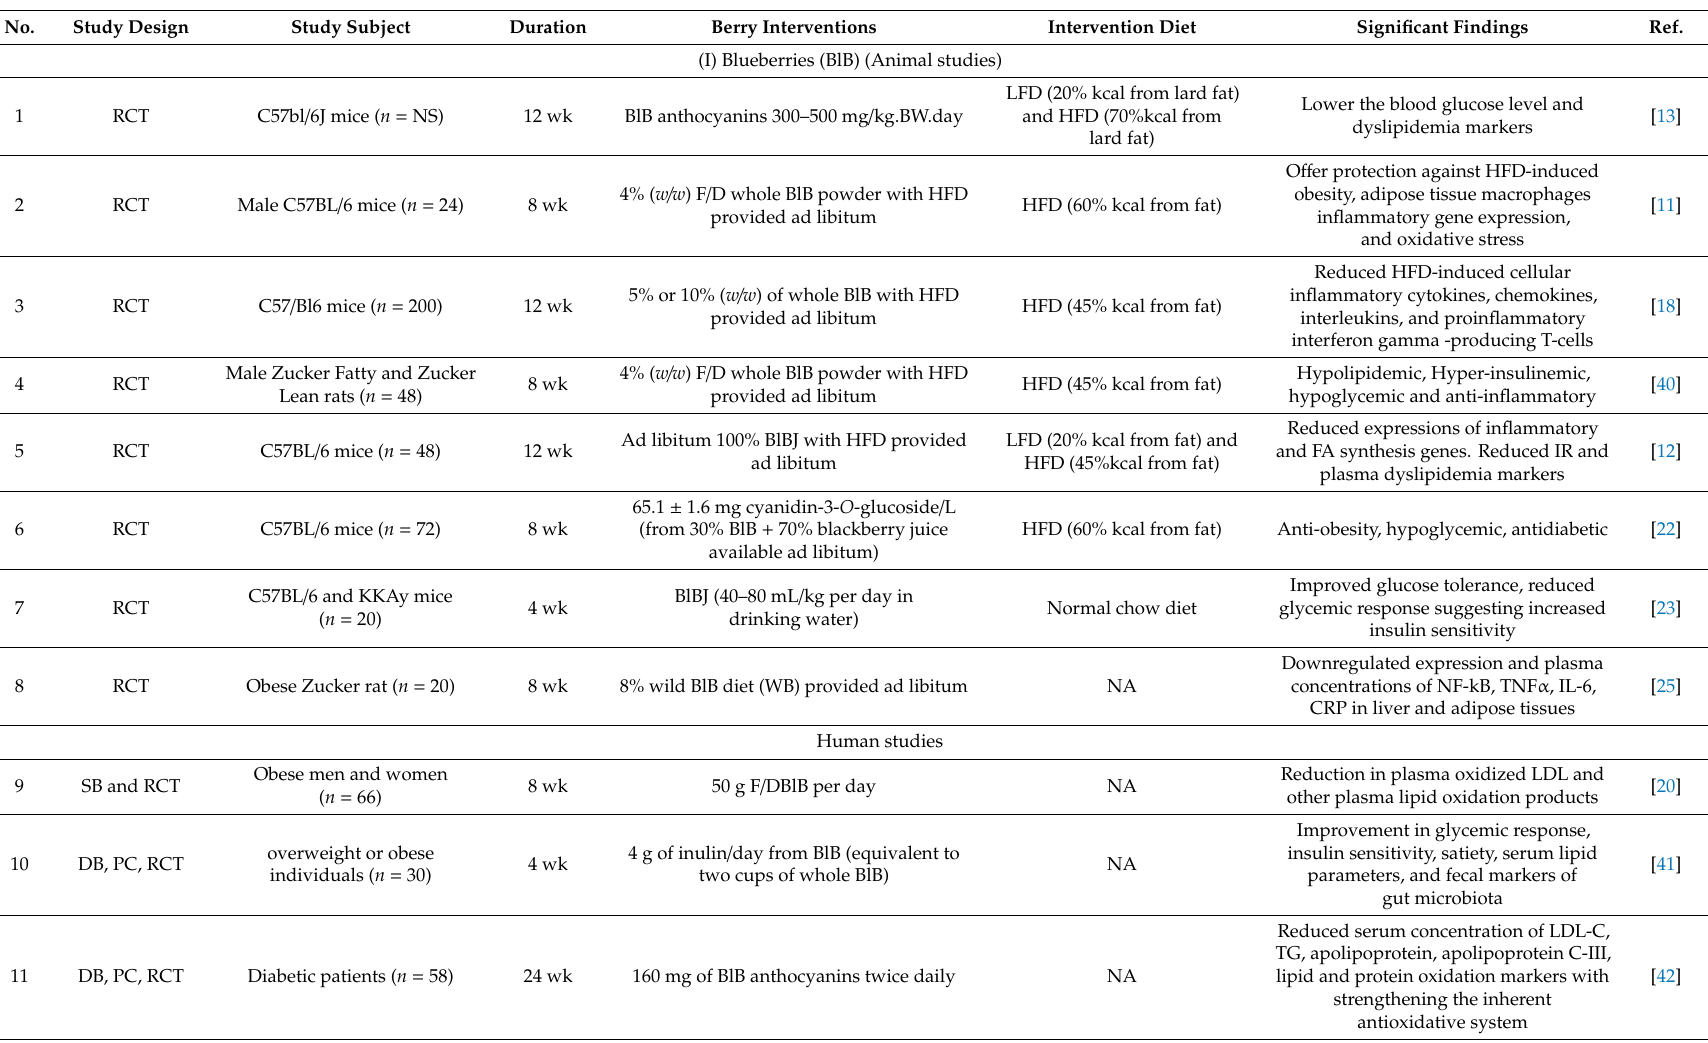
Table 1. A comprehensive list of berry interventions and their consequent e ff ects on various